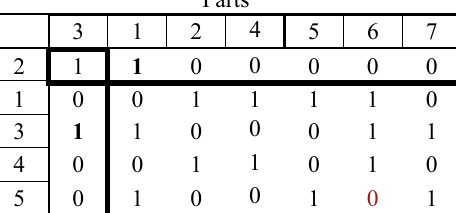
Fig. 5. First optimal 2-cell solution with minimum exceptions